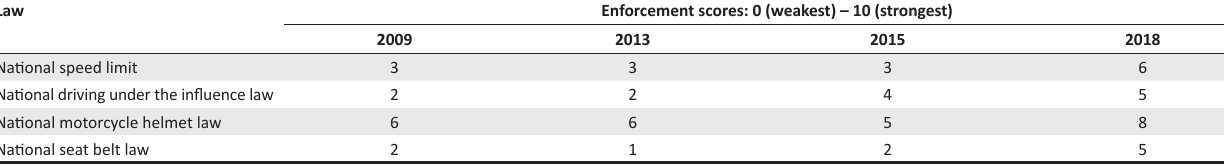
TABLE 3: Expert-provided law enforcement scores for South Africa (2009–2018). Law Enforcement scores: 0 (weakest) – 10